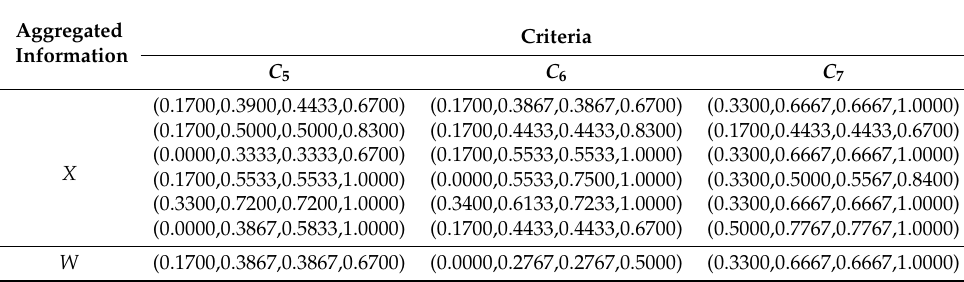
Table 11. Aggregated information of fuzzy information X and fuzzy criteria weights W -continued. Aggregated Information